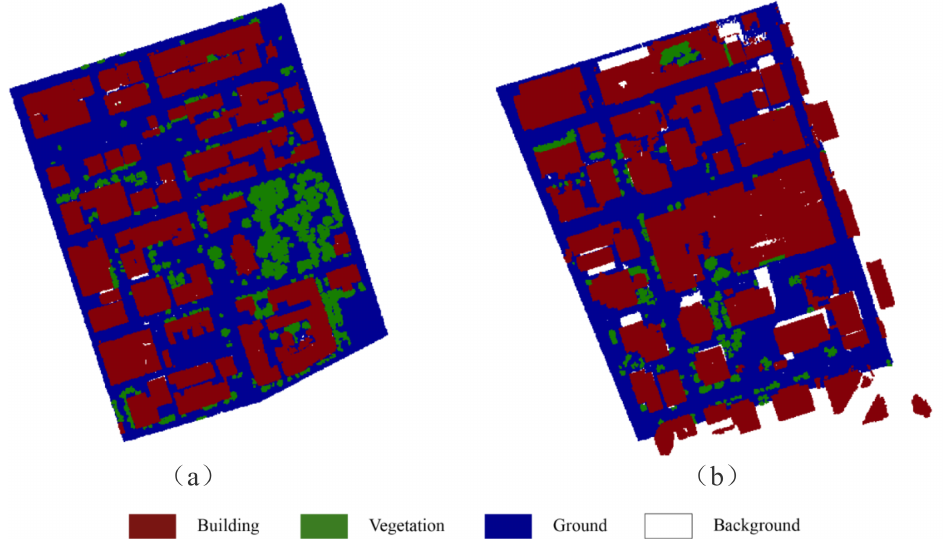
Figure 5. Classification results of two Toronto site areas. ( a ) The classification result of Area 1 and ( b ) the clasification result of Area 2.